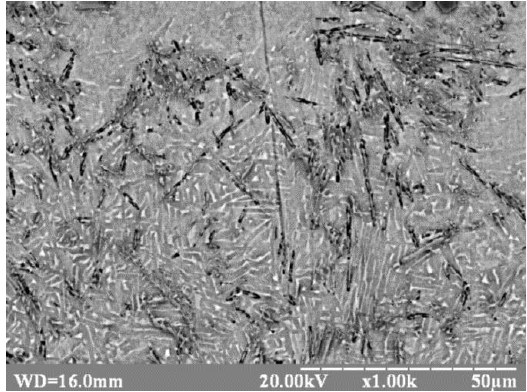
Figure 14. TiB submicron reinforcing fibers of (Ti-TiB)–T110 welded joint area in Ti-TiB—welded seam zone—after annealing at 750 °С.